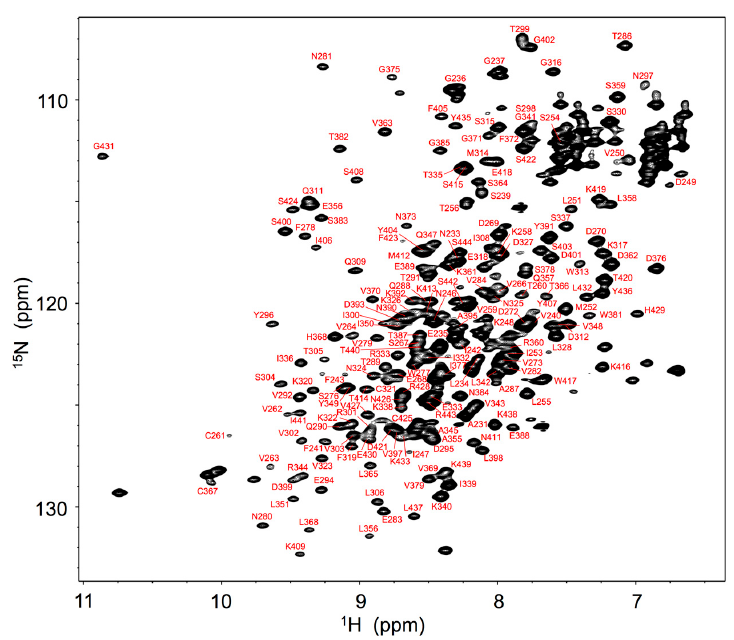
Figure 1. 1 H- 15 N HSQC spectrum of uniformly 13 C, 15 N-labeled mouse IgG2b-Fc recorded at 52 °C at 800 MHz. Backbone assignments are annotated by the resonance peaks with one-letter amino acid codes and the sequence.